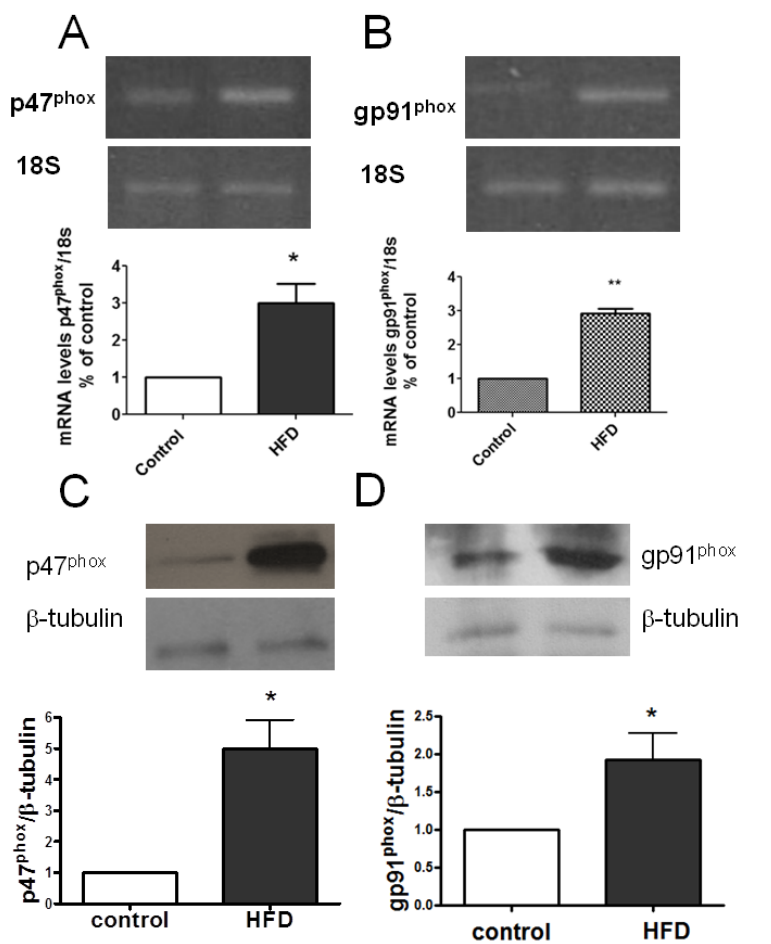
and protein in skeletal muscle. Control and insulin resistance mice were used after 14 h fasting. After euthanasia, tibialis anteriors (TAs) were dissected and triturated in TRIzol reagent. mRNA levels were analyzed by semiquantitative RT-PCR. Characteristic agarose gels of RT-PCR products are shown in the upper panel, ( A ) and ( B ). Results were normalized to 18S expression (mean ± SEM, n = 3). * p < 0.05; ** p < 0.02; ( C ) Western blot and densitometry analysis from TA (control or HFD mice); incubations with primary antibody were overnight at 4 °C with primary antibodies: anti-p47 phox , 1:1000, n = 3; ( D ) Western blot and densitometry analysis from TA of gp91 phox (membrane subunit